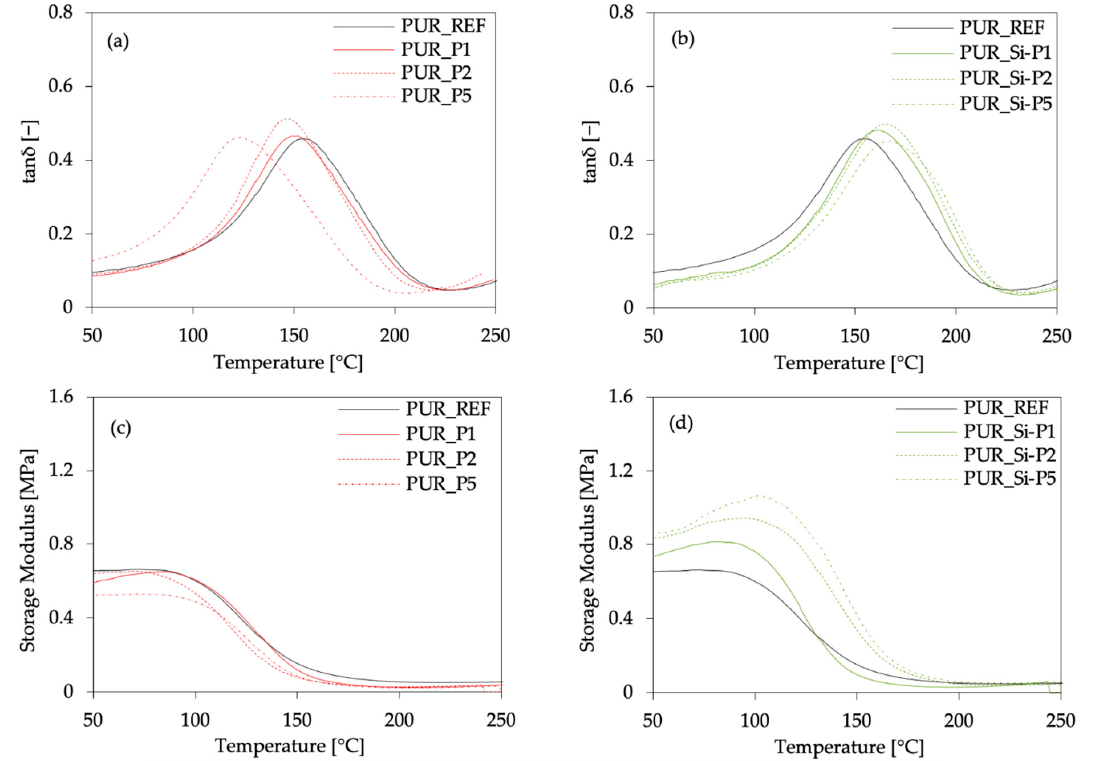
Figure 8. DMA results of PUR composites reinforced with unmodified and silanized plum fillers: ( a , b ) glass transition temperature (T g ); ( c , d ) storage modulus (E ′ ).